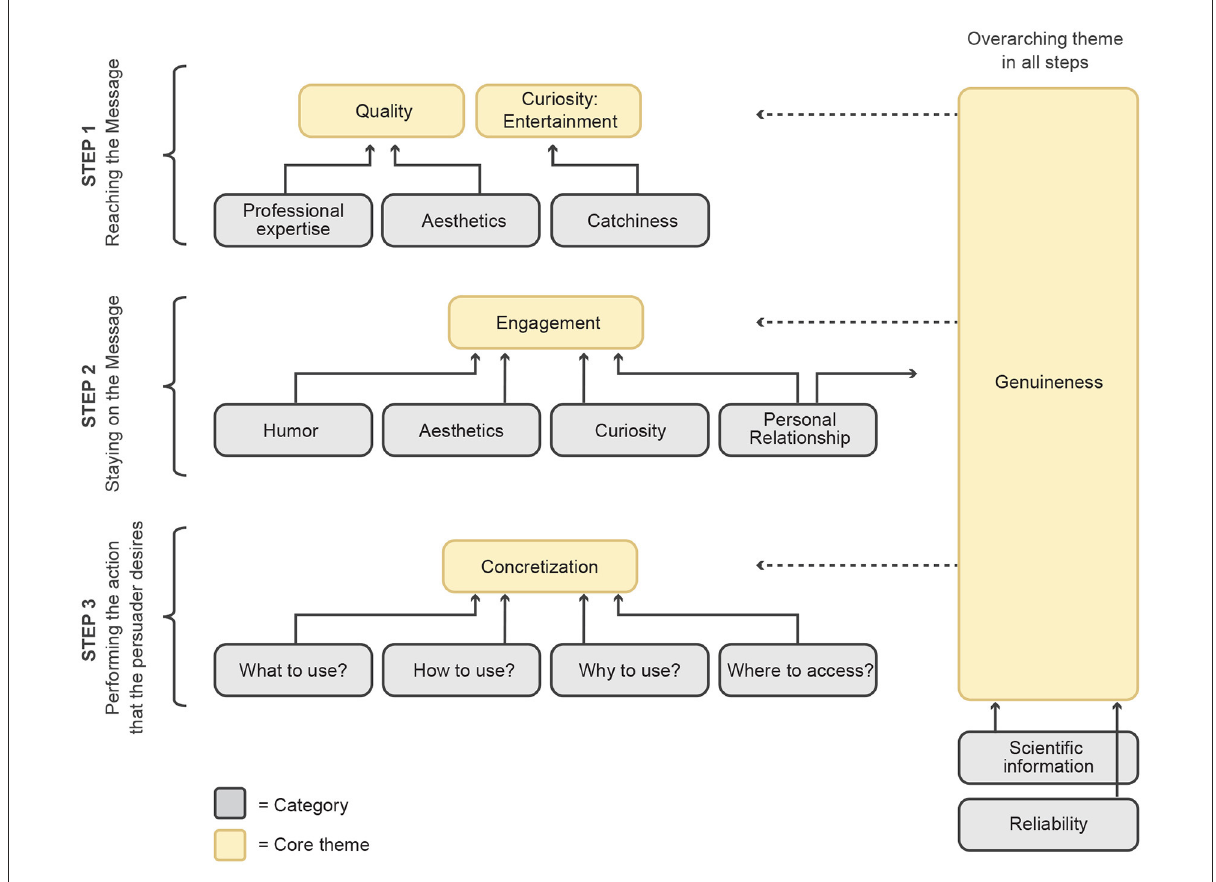
FIGURE3 The three-step model of